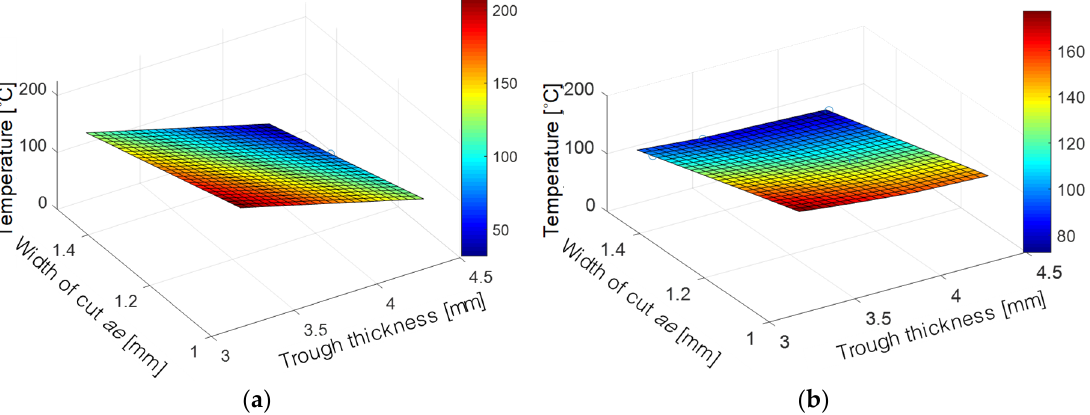
Figure 13. 3D surf mesh vertical cutting temperature for the thermocouples 3-6-8-10 and an ft of 0.05 mm/tooth, ae of 1 mm: ( a ) trend of temperature for tool2; ( b ) trend of temperature for tool3 along the stack